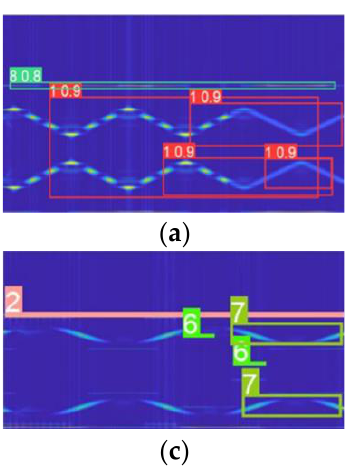
Figure 12. Training validation procedure of the four models.